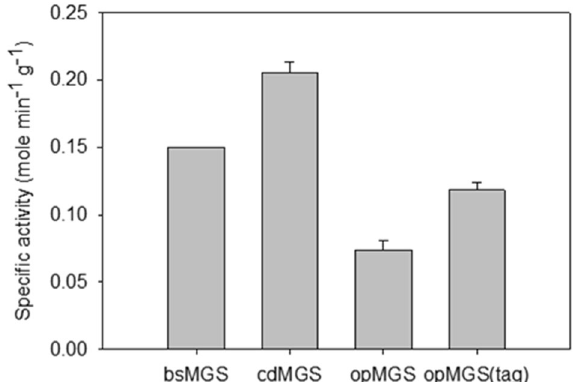
Figure 1. Specific activities of the purified MGSs at pH 7.5, 30 °C. Each value and error bar represents the mean and the standard deviation of at least three independent trials, respectively. The specific activity of bsMGS from Bacillus subtilis has been reported previously and presented here for comparison 4